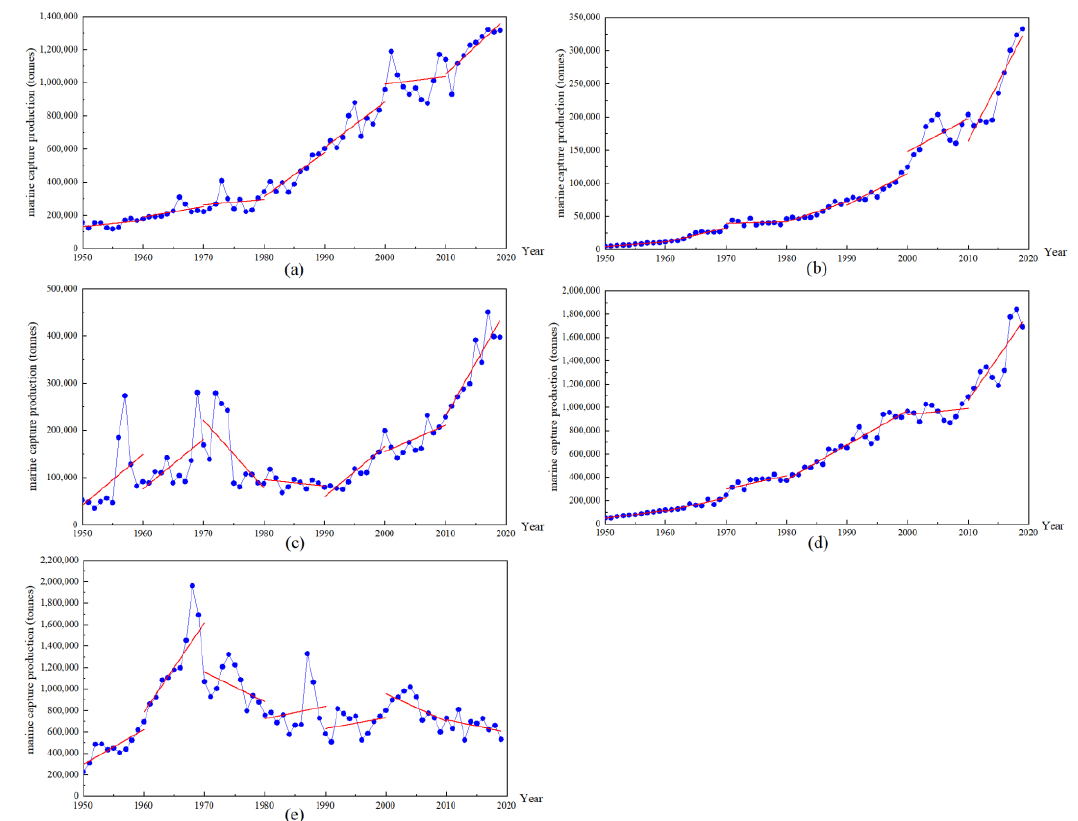
Figure 2. Trends of catches of marine fisheries in Africa during 1950 – 2019: ( a ) North Africa; ( b ) East Africa; ( c ) Central Africa; ( d ) West Africa; ( e ) Southern Africa. Note: Red lines visualize the Slope, by decade. Data sources: See Around Us Project Database (https://www.seaaroundus.org/data/#/eez, accessed on 20 October 2022).